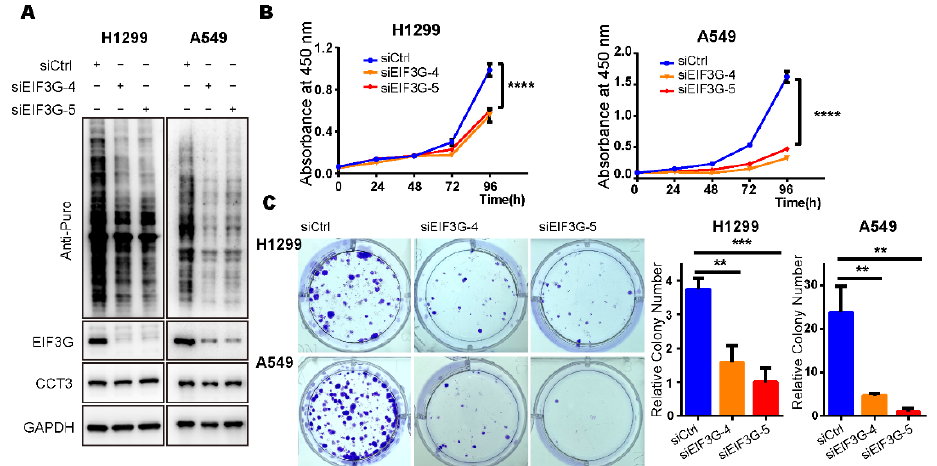
Figure 6. Knockdown of EIF3G alone inhibits the growth of LUAD cells. ( A ) Representative WB images of SUnSET assays in H1299 and A549 cells treated with siRNAs targeting EIF3G or a control. Note: 10 μ g/mL puromycin was added into culture medium to label the newly synthesized peptides in cells. ( B ) Cell proliferation (n = 5/group) in indicated cells measured with CCK8 assays. ( C ) Colony formation (n = 3/group) in EIF3G knockdown cells and corresponding control cells. Representative images of colony formation assay ( left ), relative colony number ( right ). Data are shown as mean + SD, ** p < 0.01, *** p < 0.001, **** p < 0.0001, two-tailed Student’s t -test.